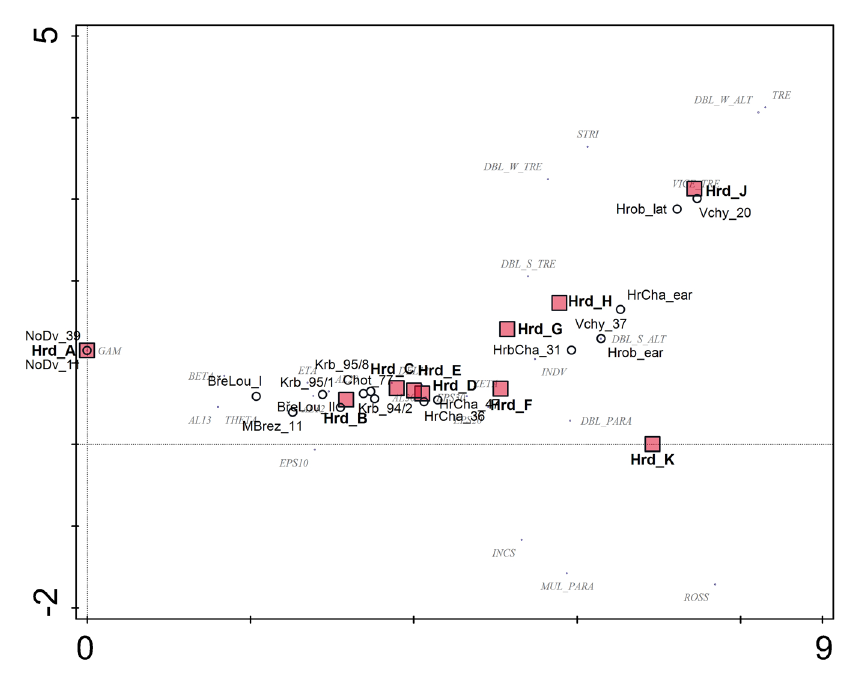
Figure 6. Detrended correspondence analysis of referential and Hrdlovka settlement horizons assemblages. First ordination axe explains 19.6 %, second 8.5 % of variability. The delta 12 decoration style is supplementary